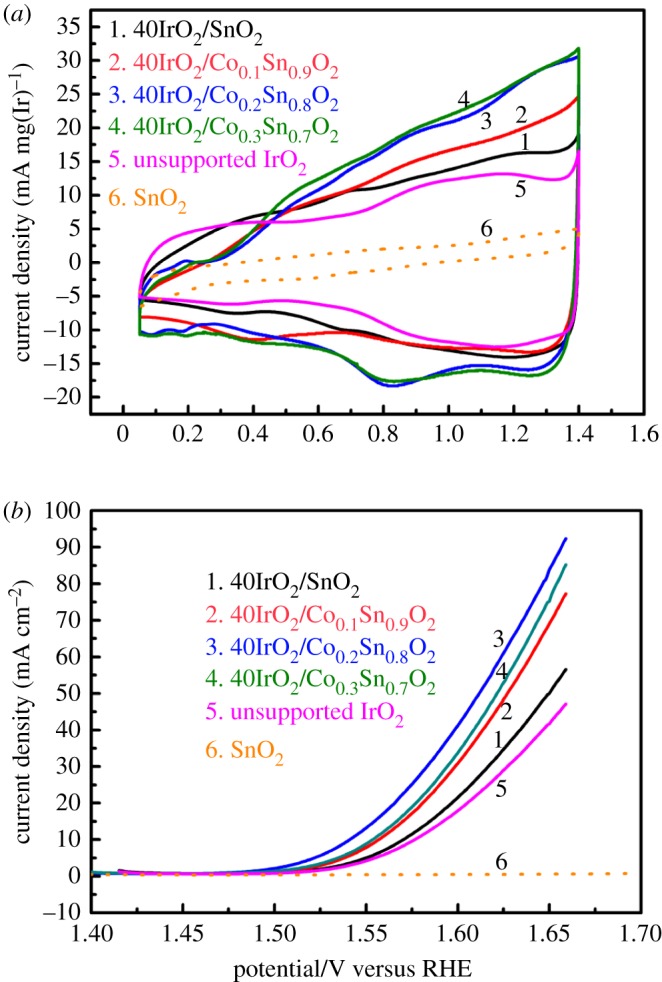
(a) Cyclic voltammetry curves of 40IrO2/CoxSn1−xO2, pristine SnO2 and unsupported IrO2 in N2-saturated 0.5 M H2SO4 solution at a scan rate is 50 mV s−1 and (b) LSV curves of 40IrO2/CoxSn1−xO2, pristine SnO2 and unsupported IrO2.